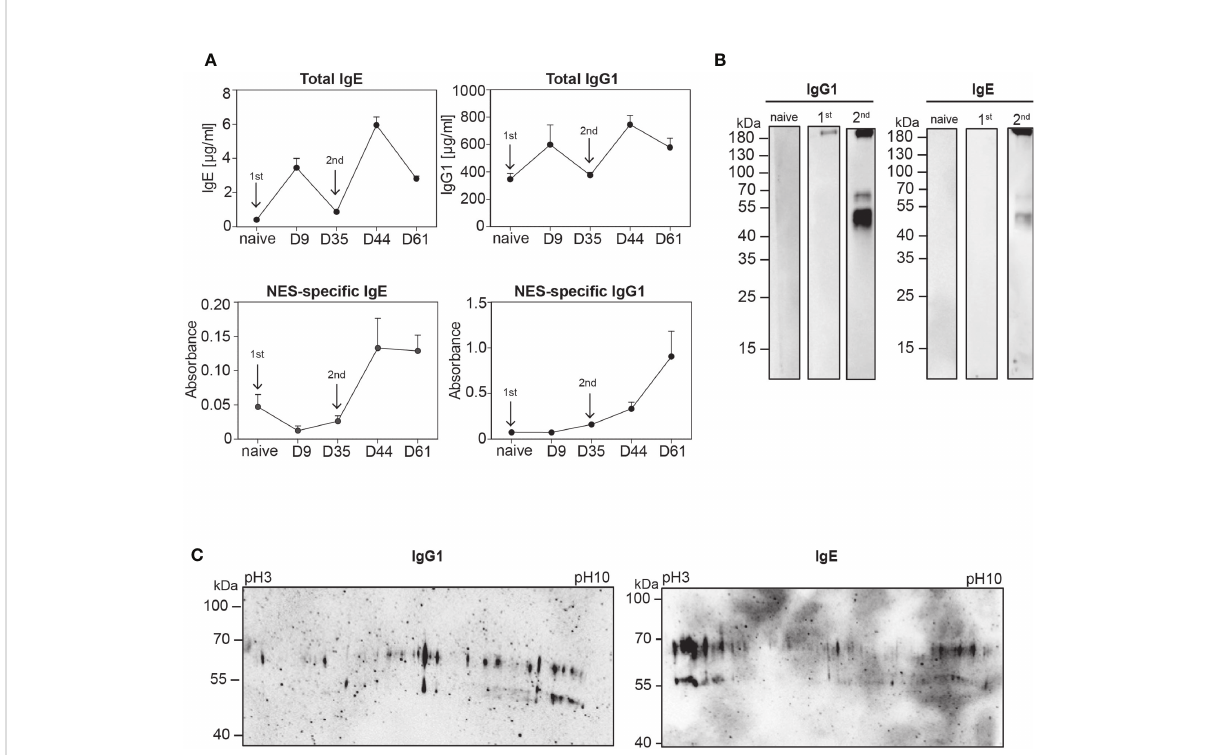
FIGURE 1 Polyclonal IgE and IgG1 antibodies from secondary Nb- infected mice recognise a discrete set of Nb antigens. (A) Graphs display kinetic of total (upper row) and NES-speci fi c (lower row) serum IgE and IgG1 antibodies during the course of Nb infection, collected at indicated time points after primary (1 st ) and secondary (2 nd ) Nb infection (arrows) of wild-type mice or from naïve mice. Mean+SEM with 2-6 mice per group. (B) NES from L3 stage larvae were separated by standard SDS-PAGE under non-reducing conditions. Western blots were performed with serum from naïve, 1 st or 2 nd Nb- infected mice, following detection with either anti-mouse IgE or anti-mouse IgG1. (C) Representative 2D Western blots of NES hybridized with serum from mice after 2 nd Nb infection, followed by detection with either anti-mouse IgE or anti-mouse